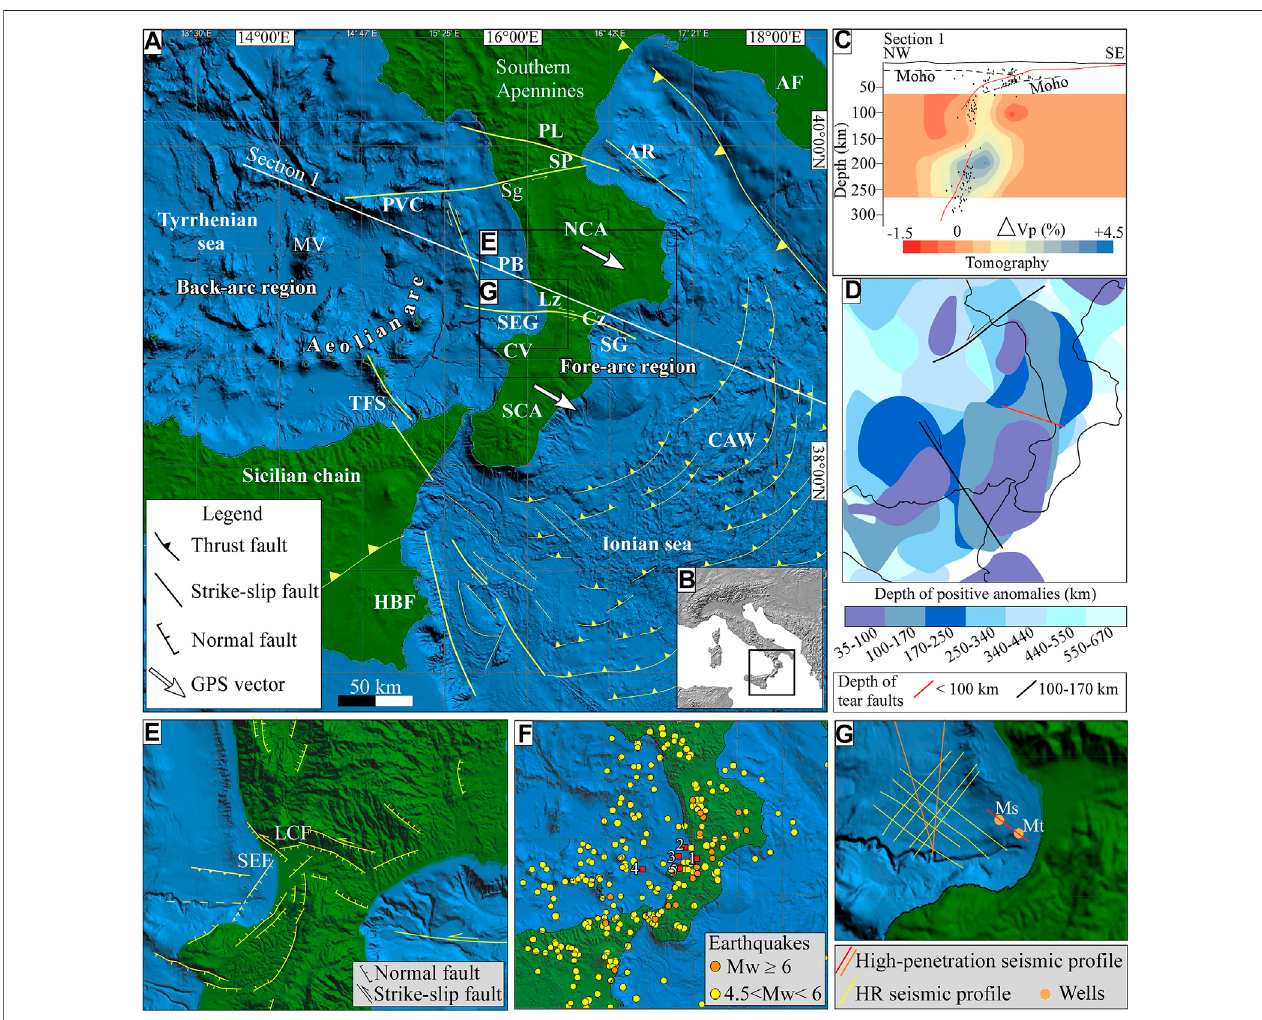
FIGURE 1 | (A) Schematic tectonic map of the Tyrrhenian-Ionian subduction system. AF, Apulian foreland; AR, Amendolara ridge; CAW, Calabrian accretionary wedge; CV, Capo Vaticano; Cz, Cosenza; HBF. Hyblean foreland; Lz, Lamezia; MV, Marsili volcano; NCA, northern Calabrian Arc; PB, Paola basin; PL, Pollino; PVC, Palinuro volcano complex; SCA, southern Calabrian Arc; SEG, Sant ’ Eufemia Gulf; Sg, Sangineto; SG, Squillace Gulf, SP, Sibari Plain; TFS, Tindari fault system. (B) Location of the area shown in panel a. (C) Section across the slab (modi fi ed from Maesano et al., 2017). Redline is the position of the subduction interface. Black dots are the earthquakes collected in 10-km wide buffers around the section trace. The dashed black line is the position of the Moho from Scrocca et al., 2003. Tomographic data are from Neri et al., 2009. (D) Upper mantle structure based on positive P wave seismic anomalies (modi fi ed from Rosenbaum et al., 2008). The coloured areas represent positive anomalies at different depth ranges. Rosenbaum et al., 2008 interpreted these areas as remnant subducting slabs, separated by tear faults(blackandredlines). (E) SchematictectonicmapofthecentralCalabrianArc(modi fi edfromMonacoandTortorici,2000;Bruttoetal.,2016)andoffshore(modi fi ed fromLoretoetal.,2013;DelBenetal.,2008).LCF,Lamezia-CatanzaroFault;SEF,Sant ’ EufemiaFault. (F) Distribution ofinstrumentalearthquakesrecordedsince1985 up-to-date, from INGV Seismic Bulletin (ISIDe Working Group, 2007; http://iside.rm.ingv.it). Red squares indicate the 1905 epicentral location proposed by (1) Rizzo, (1906), (2) Riuscetti and Schick, (1975), (3) Camassi et al. (1997), (4) Michelini et al. (2006), (5) Guidoboni et al. (2007). (G) Grid of high-penetration and high-resolution (HR) seismic pro fi les used for this study. Ms, Marisa well; Mr, Marta